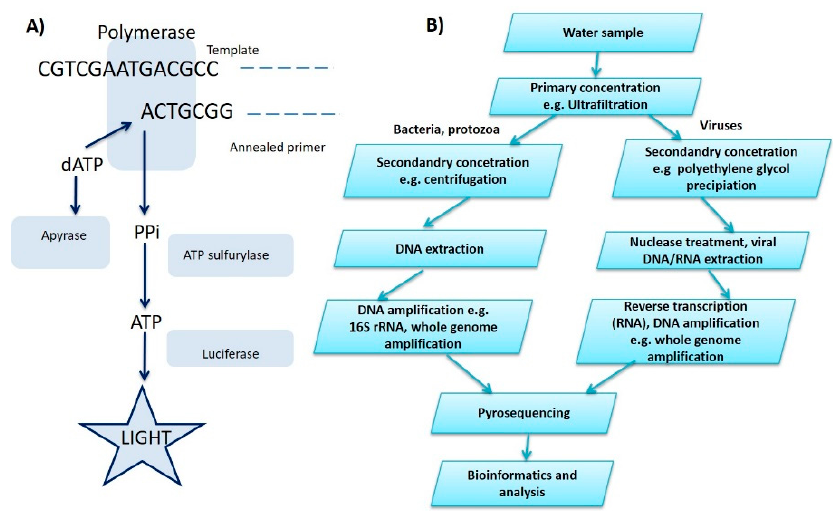
Figure 2. ( a ) Schematic illustration of the pyrosequencing reaction with four enzymes (DNA polymerase, ATP sulfurylase, luciferase, and apyrase). Nucleotides are added one at a time to form the complementary strand of the single-stranded template, to which a sequencing primer has been annealed. Each nucleotide incorporation event is accompanied by the release of pyrophosphate (PPi). ATP sulfurylase converts the PPi into ATP. The ATP is then converted to visible light by luciferase and the produced light signal is detected. Unincorporated nucleotides and ATP are degraded by apyrase between each cycle. ( b ) Major steps in the metagenomic detection of microbial pathogens in water by pyrosequencing. (Modified from Aw and Rose [38] Copyright (2011), with permission from Elsevier).